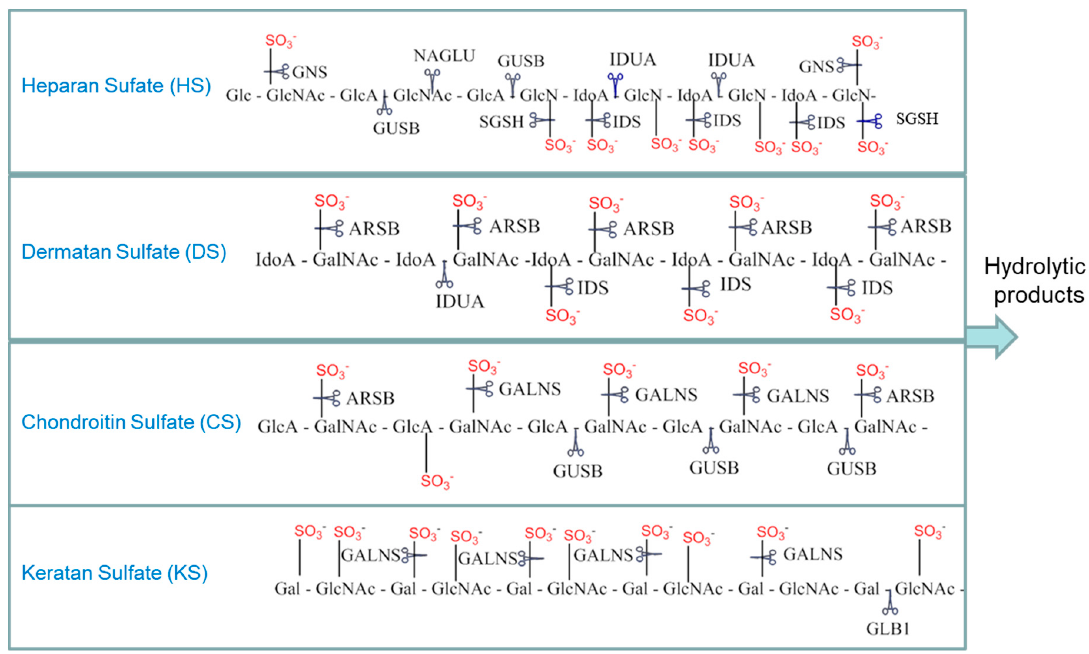
Figure 1. Select examples of glycosaminoglycan breakdown by the mucopolysaccharidoses (MPS) enzymes. Scissors indicate the sites cleaved in each of the glycosaminoglycans (GAGs) by the various MPS enzymes. HGSNAT (not shown) is a transferase that adds an acetyl group to glucosamine residues. GUSB also cleaves dermatan sulfate after GlcA residues are exposed by other enzymes. Gal: galactose; GlcA: glucuronate; IdoA: iduronate; GlcNAc: N -acetylglucosamine; GalNAc: N -acetylgalactosamine; IDUA: α -iduronidase; IDS: α -iduronide sulfatase; SGSH: N -sulfoglucosamine